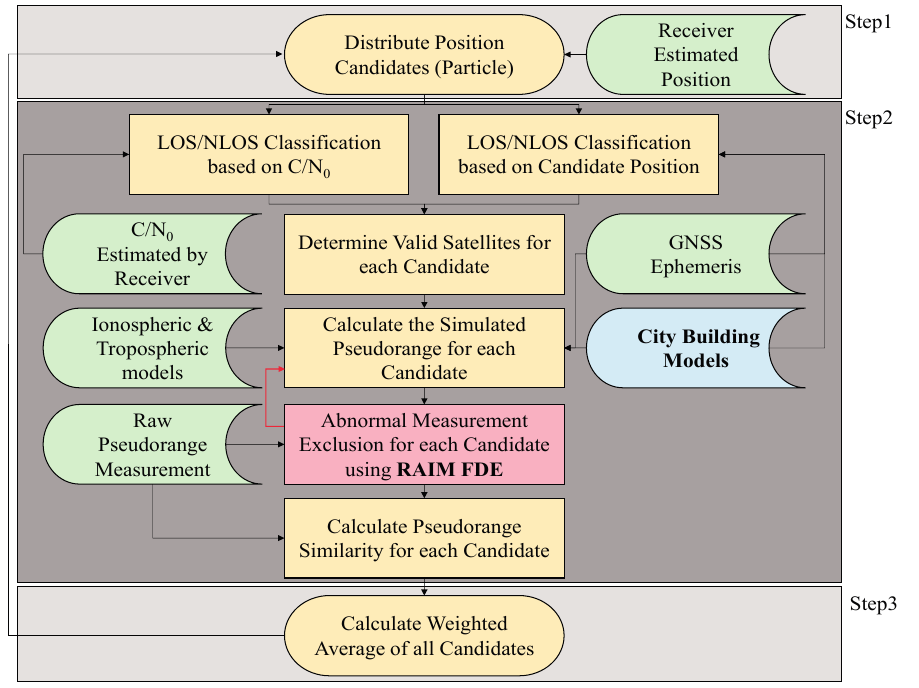
Figure 4. Flowchart of the particle filter using 3D city building models and receiver autonomous integrity monitoring (RAIM) multiple fault detection and exclusion